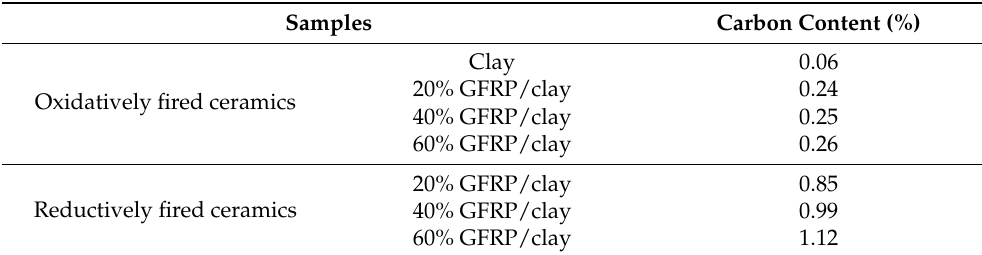
Table 4. Carbon contents of